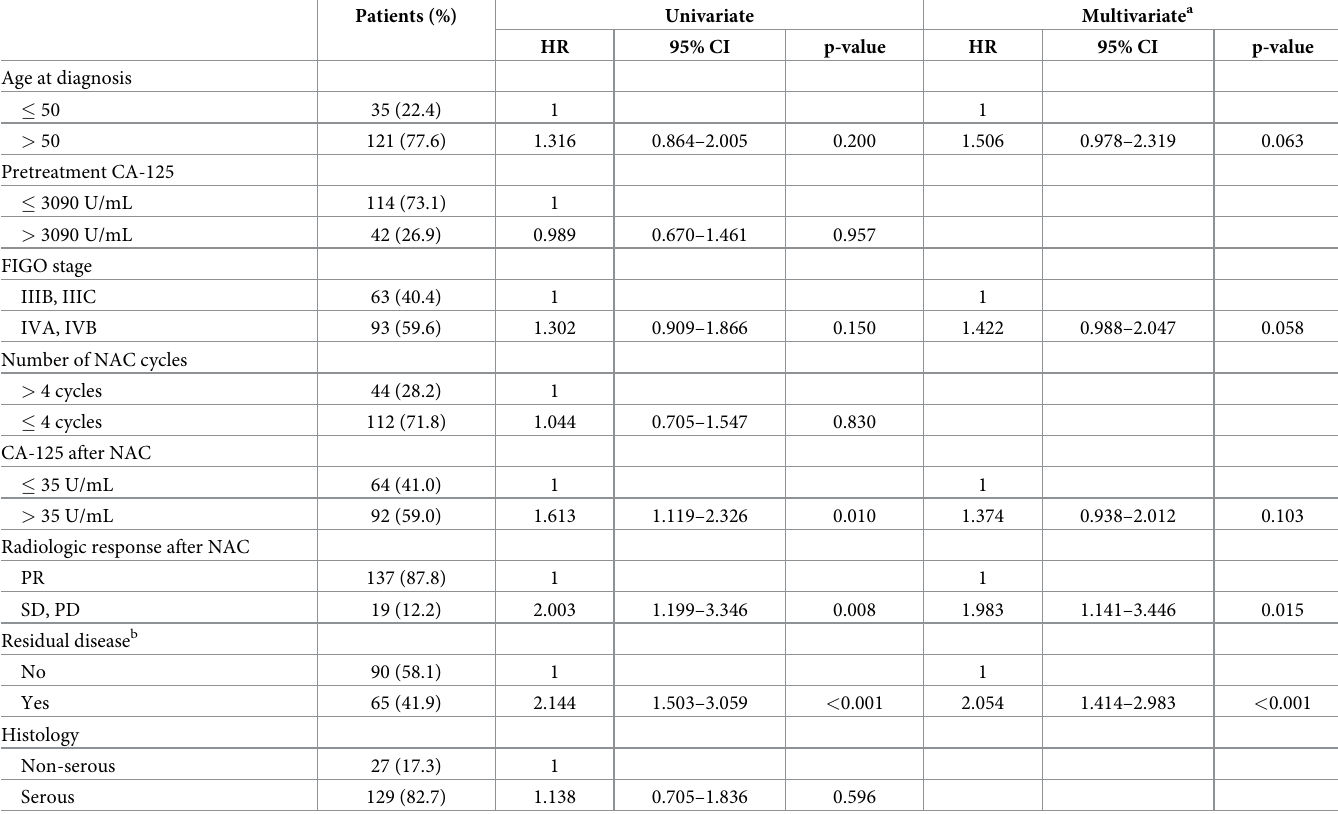
Table 4. Univariate and multivariate Cox regression analysis for progression-free survival.